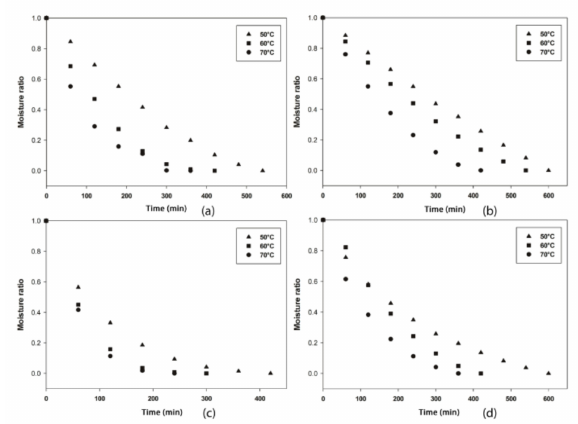
Figure 3. Drying characteristics of persimmon fruit sliced samples; ( a ) vacuum drying (VD) of sample thickness of 5 mm; ( b ) VD of 8 mm; ( c ) hot-air drying (HAD) of 5 mm; ( d ) HAD of 8 mm.